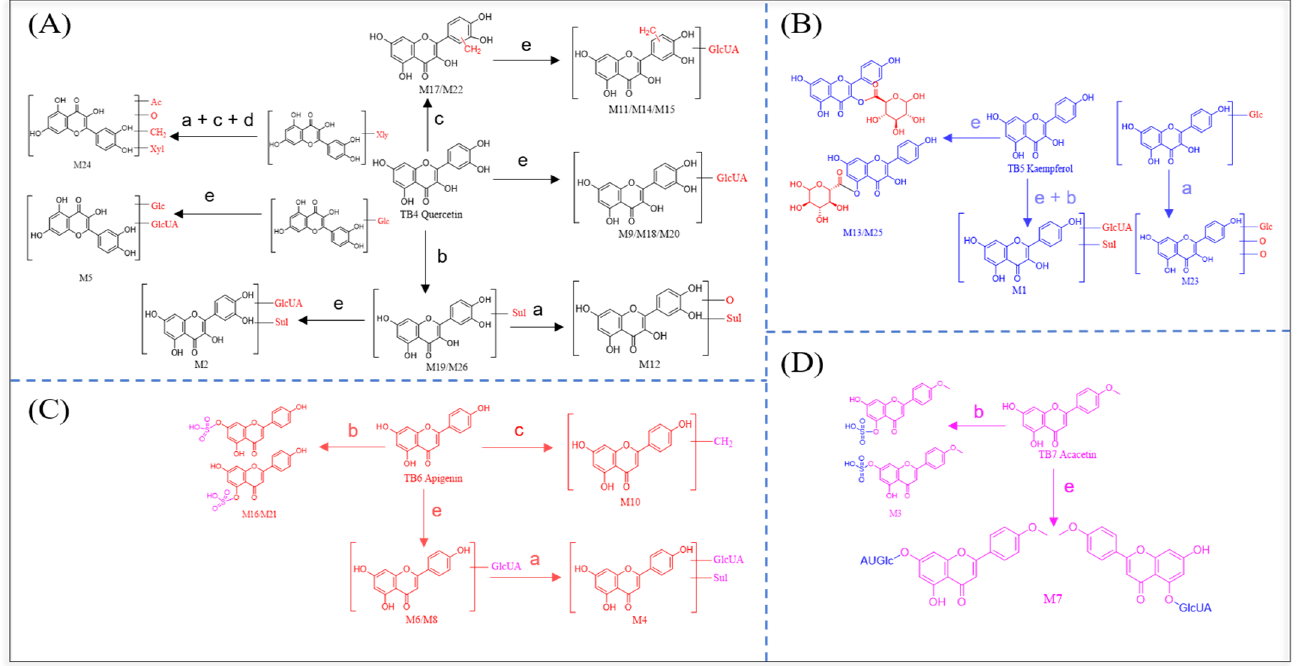
Figure 5. The proposed metabolic pathways of ( A ) quercetin, ( B ) kaempferol, ( C ) apigenin and ( D ) acacetin in Tartary buckwheat extracts in rat biological samples (a. hydroxylation, b. sulfation, c. methylation, d. acetylation, e. glucuronidation).